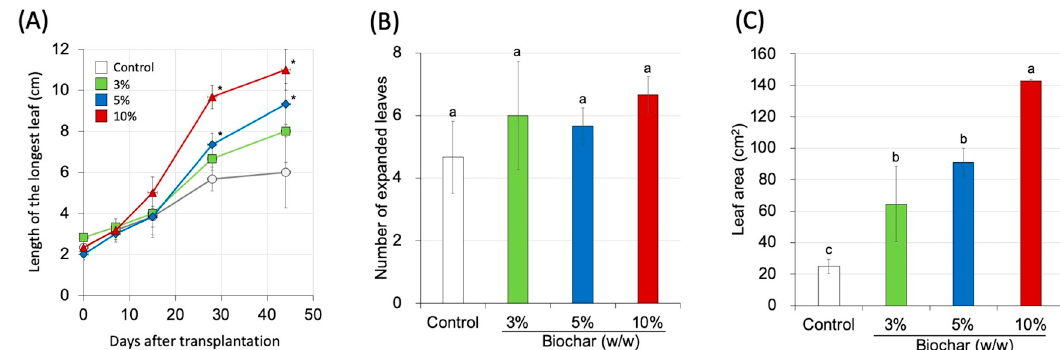
Figure 4. Effects of jatropha fallen leaf biochar application to the experimental soil on the growth of Swiss chard plants. Biochar was applied to the experimental soil at three levels (3%, 5%, and 10% (w/w)) and the growth of Swiss chard plants in the amended soils and unamended control soil was compared. ( A ) Temporal changes in the length of the longest leaf after transplantation in the biochar-amended soils. ( B ) Number of expanded leaves and ( C ) total leaf area per plant at harvest (44 days after transplantation). Values are means ± standard deviations ( n = 3 plants). Significant differences are indicated by asterisks in ( A ) ( t -test, p < 0.05) and different letters in ( B ) and ( C ) (Holm’s test, p < 0.05).